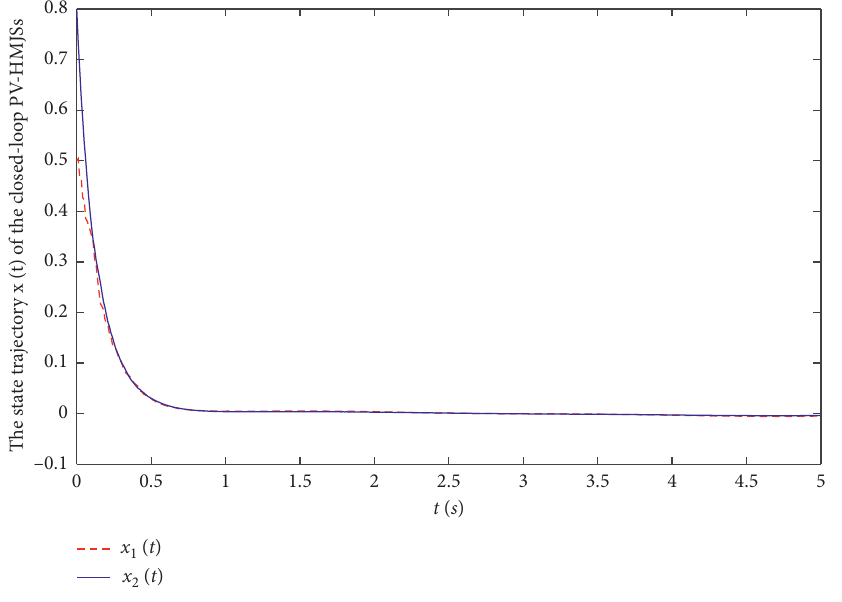
Figure 2: The x ( t ) of the closed-loop PV-HMJSs.